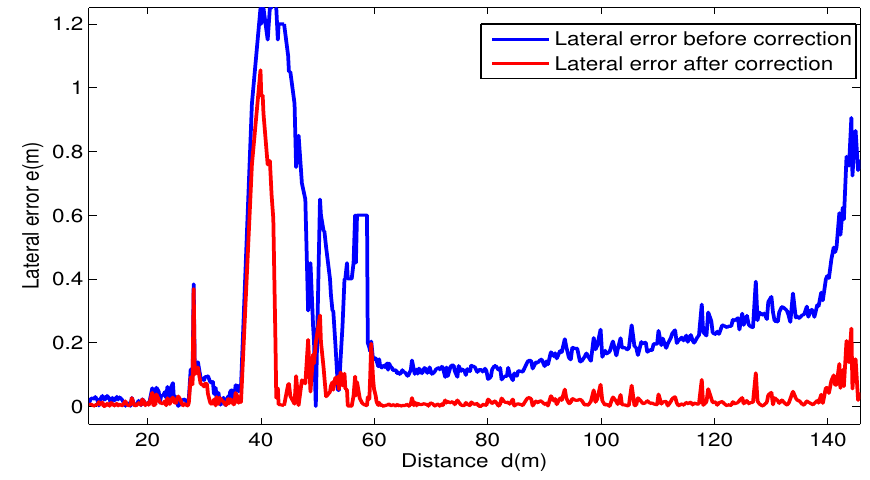
Figure 14. Lateral errors before and after lateral